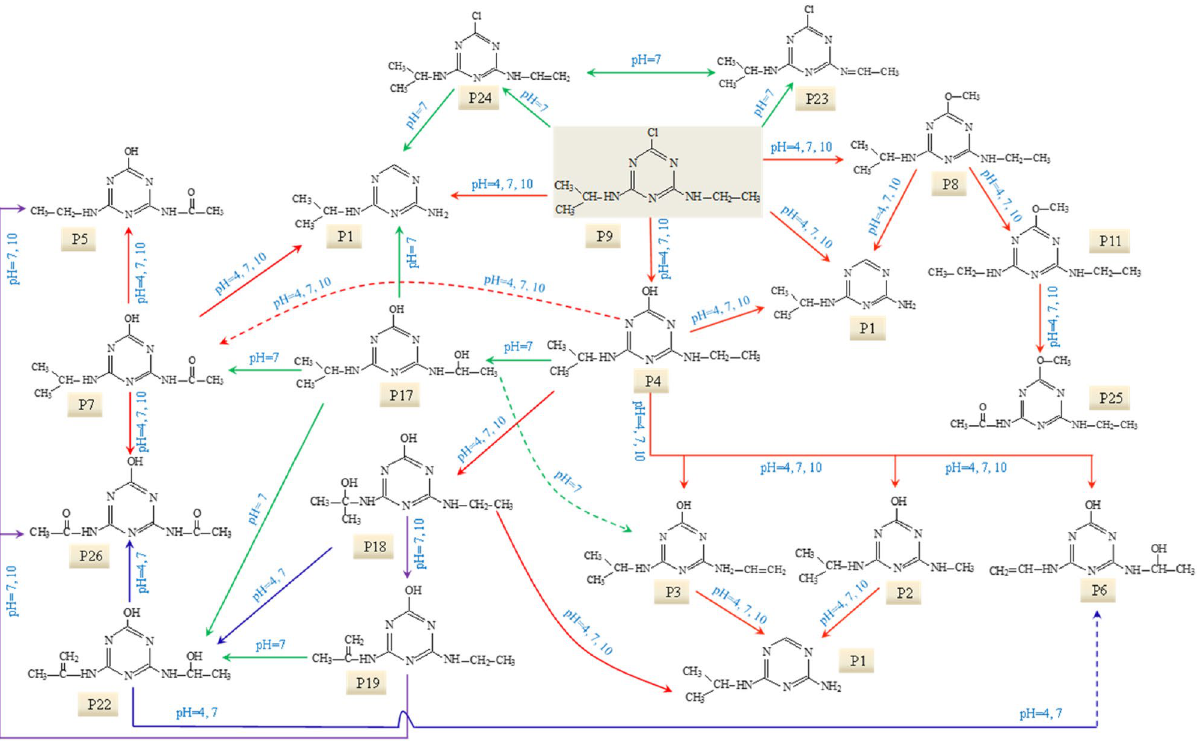
Figure 7. The proposed degradation pathway of ATZ in UV/TiO 2